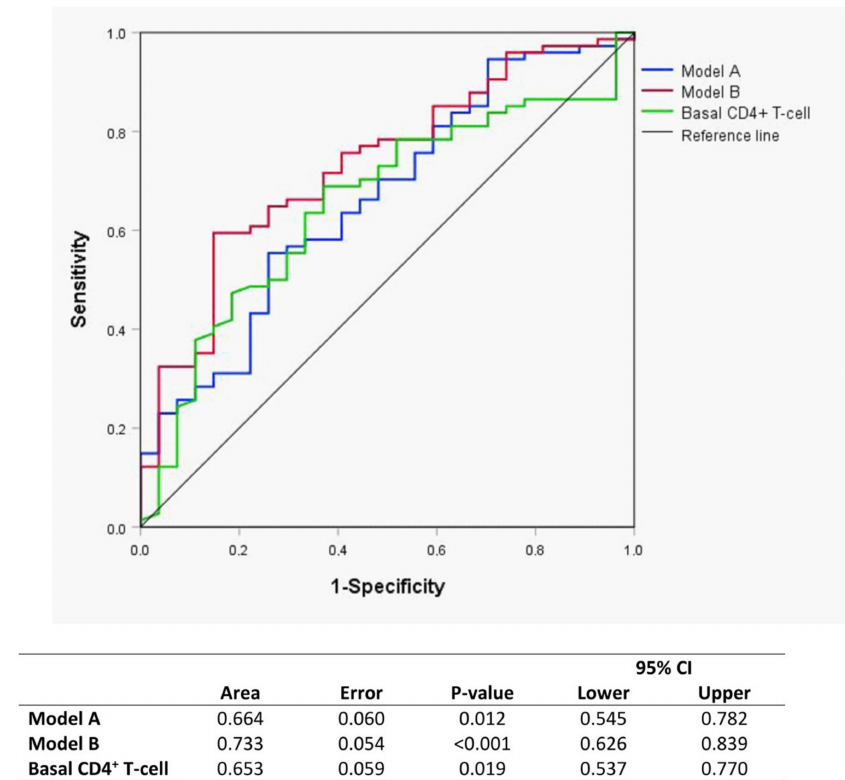
Figure 2. Receiver-operating characteristic curves (ROC) curves of Model A (blue) and Model B (red) for evaluating glycoprotein biomarkers as predictors of the immunological response to ART at baseline. Model A: Area GlycA, Area GlycB, height / width (H / W) GlycA and H / W GlycB. Model B: Model A, basal CD4 + T-cell count and age.